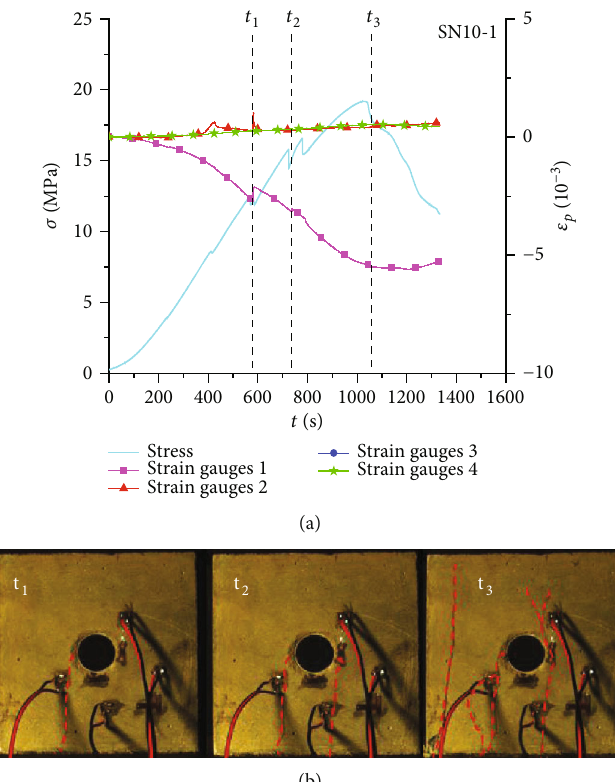
Figure 11: (a) Relationship between local strain and stress of specimen SN10-1 with loading time. (b) The relationship between the crack growth shape of specimen SN10-1 and loading